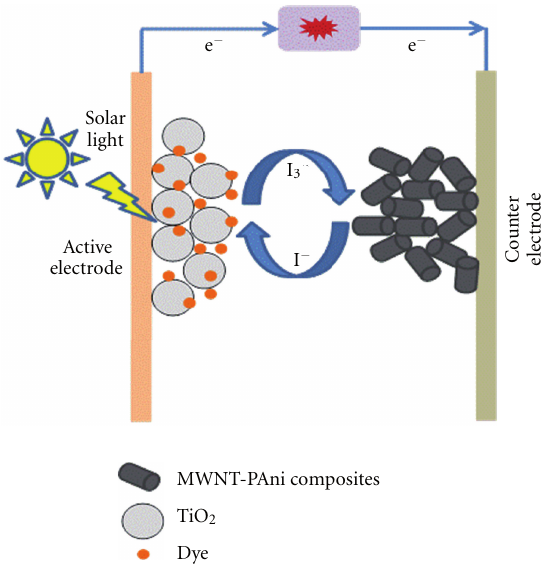
S 1: Schematic design of the charge transport processes in a typical DSSC with a quasi-solid-state composite electrolyte containing the MWNT-PAni hybrid composites and